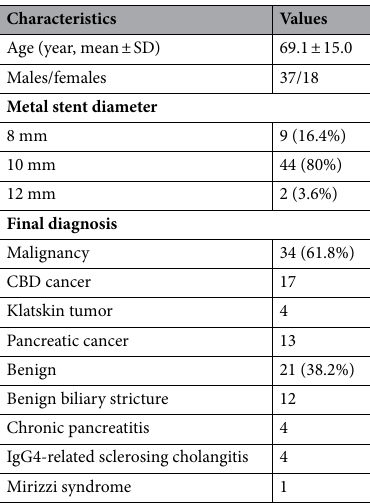
Table 1. Demographic and clinical features of the analyzed population. CBD common bile duct, SD standard deviation.